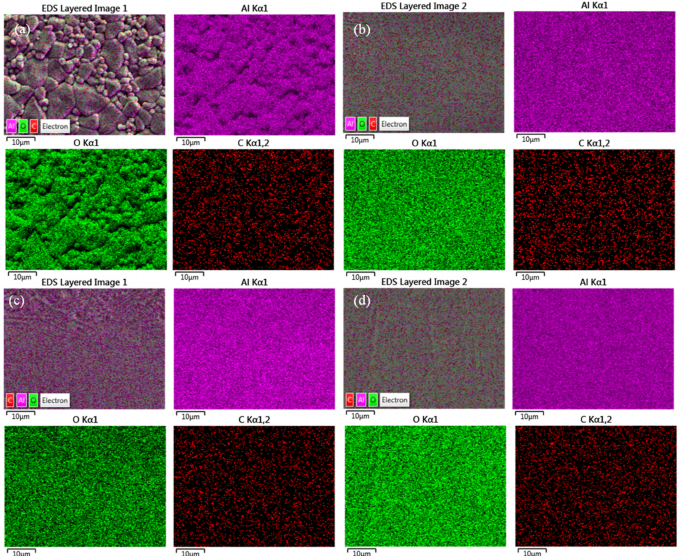
Figure 7. Elemental analysis before and after EDS polishing. ( a ) 0#, original surface, ( b ) 1#, normal temperature, ( c ) 2#, preheating 450 ◦ C, ( d ) 3#, preheating 900 ◦ C.